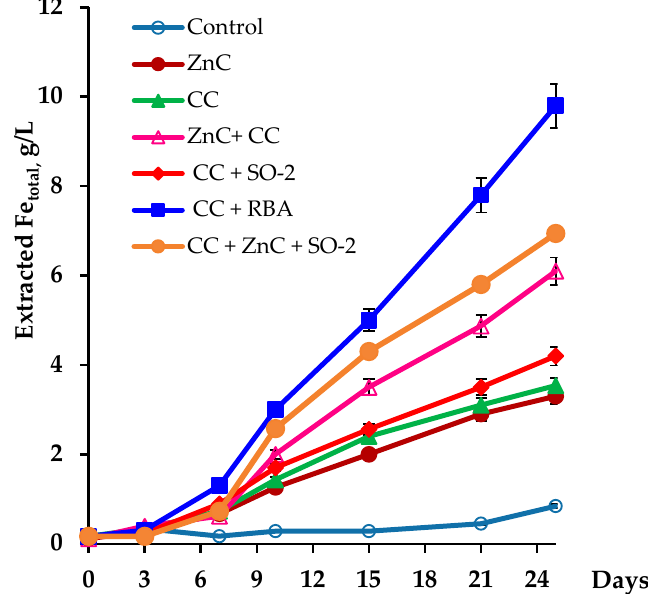
Figure 6. Bioleaching of pyrite by mono and mixed cultures of L. ferriphilum CC, At. ferrooxidans ZnC, At. albertensis SO-2, and Acidocella sp. RBA (T 35°C; pH 1.8; 180rpm; PD 4%).